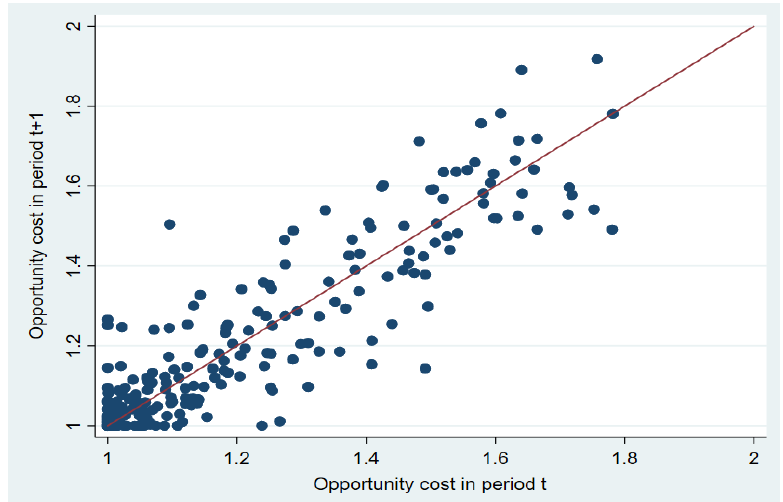
Figure 6. Change in opportunity cost by province over time. Note: The points in the figure represent the regional OC. The horizontal line represents the OC of the region in period t , and the vertical line represents the OC in period t + 1. The 45-degree line shows that regional OC does not change in two consecutive years. If the point is above the line, this means the OC increase from period t to t + 1; if the point is below the line, this means the OC decrease from t to t + 1. Table 3. The results of the mediation